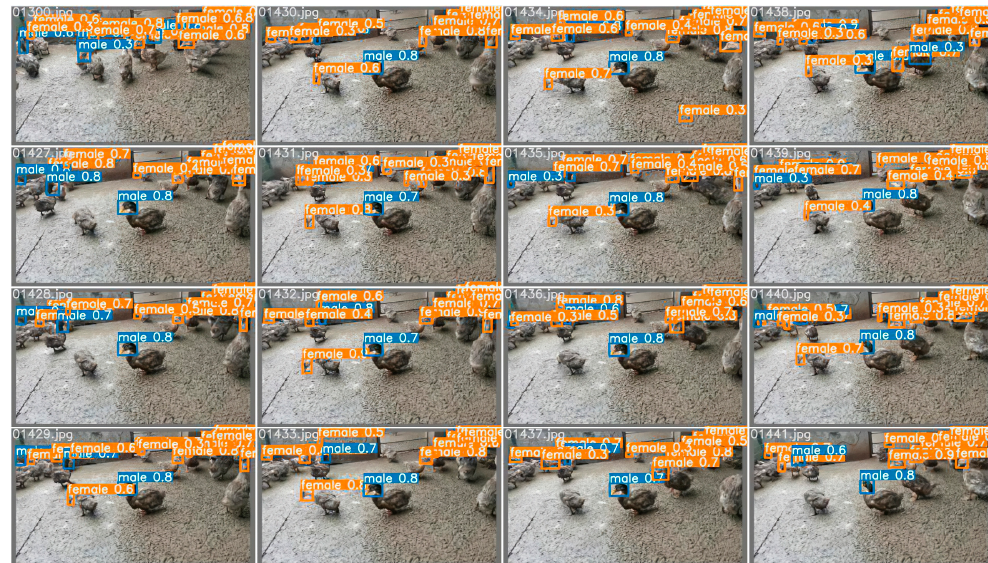
Figure 16. The sample results of scheme two. The locations, masking conditions, and individual behaviors of the ducks vary in each extracted frame. Change to the training dataset reduces the number of additional noise points and slightly improves the success of duck detection and the accuracy of gender estimation, but the accuracy is still not